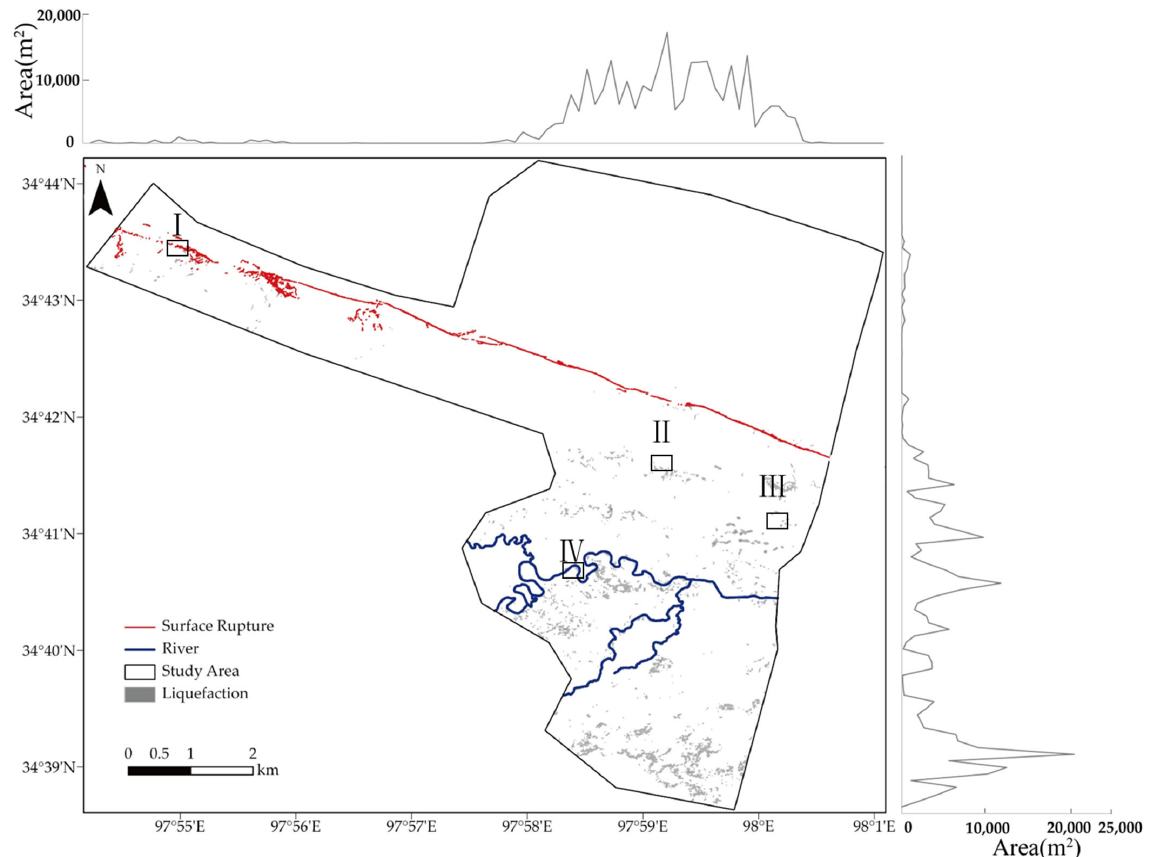
Figure 6. The distribution of liquefaction predicted by GBDT when the number of training samples was 270; the surface rupture data came from [20].